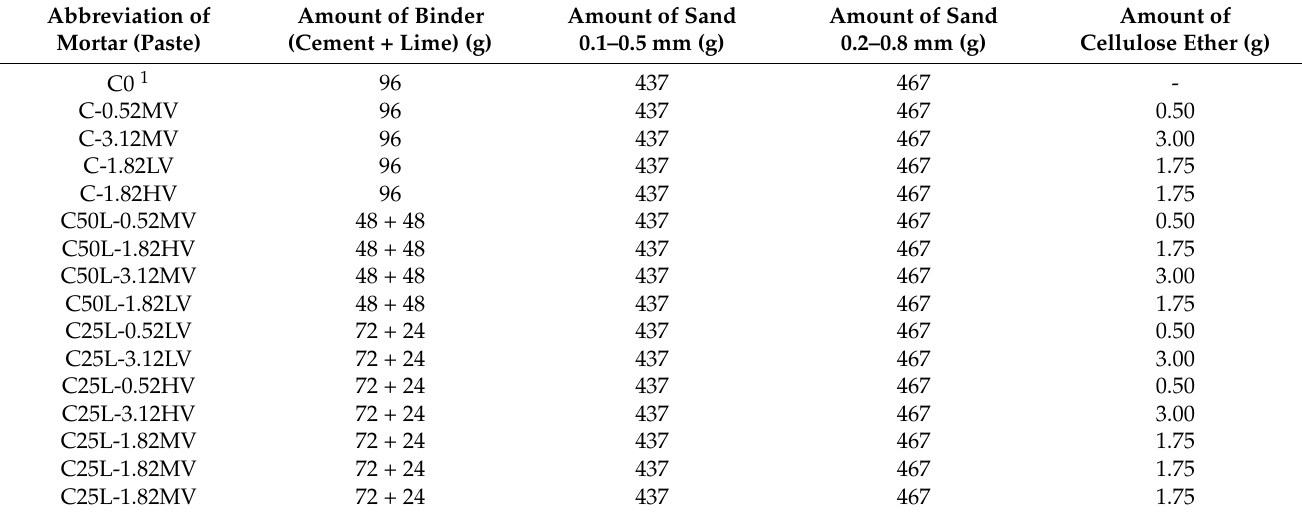
Table 5. Mortar and paste compositions defined according to the Box–Behnken